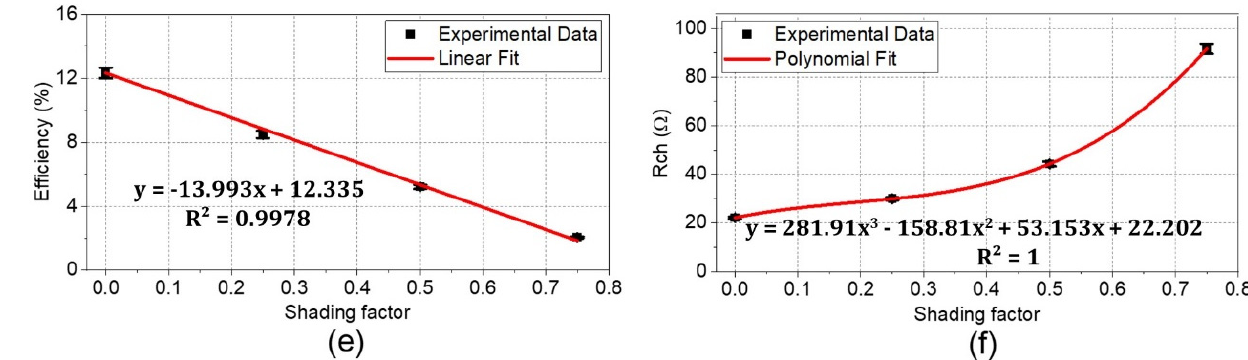
Figure 6. The variation of the performance parameters with shading: ( a ) Maximum power; ( b ) Short circuit current; ( c ) Open circuit voltage; ( d ) Fill factor; ( e ) Efficiency; ( f ) Characteristics resistance. Each data point in the figures represents the average value of the data extracted from two I-V curves with each I-V curve formed using the average of three measurements. The error bars were determined from 12 measurements taken without shading in STCs.